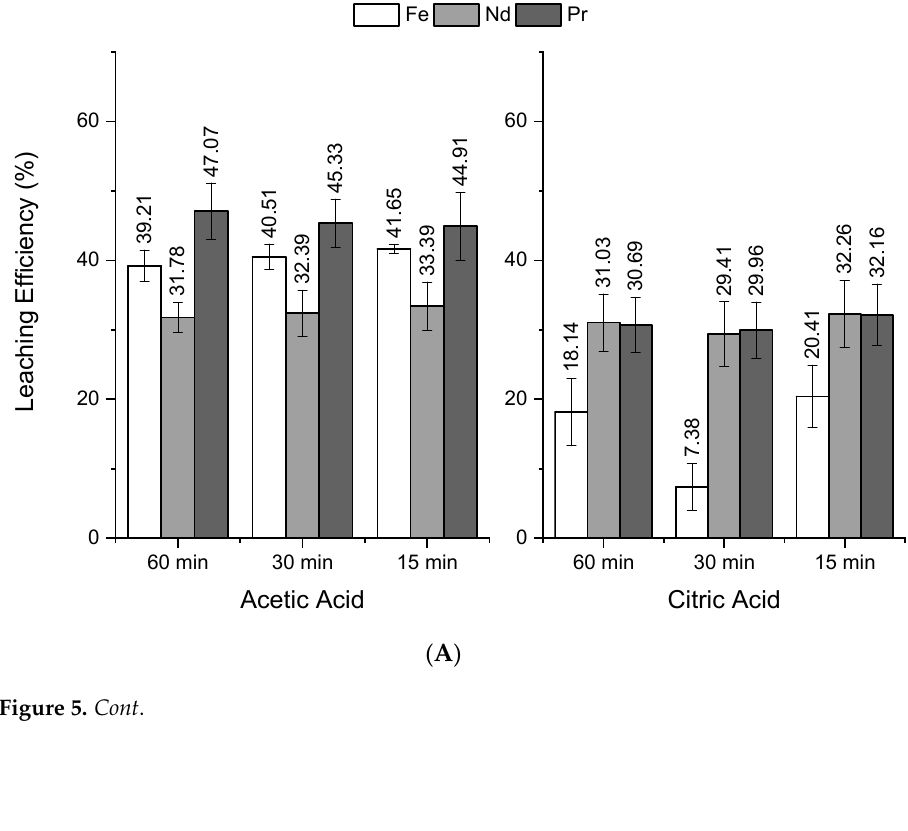
Figure 4. Comparison of the leaching efficiency of NdFeB magnets in acetic and citric acids, concen- tration 0.5 M, ratio s/l ( A ) 1/100; ( B ) 1/50 and ( C ) 1/10.